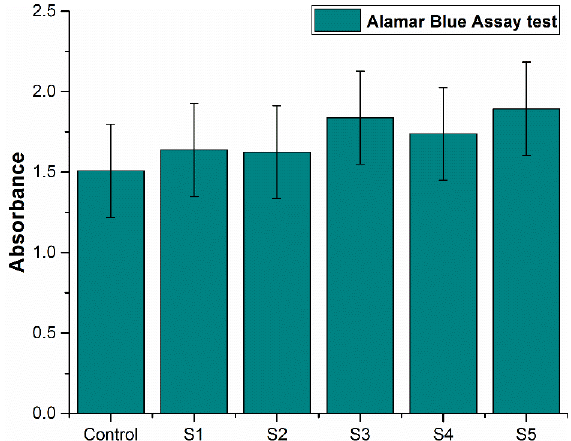
Figure 9. Cytotoxicity assessment of all the specimens. Metals 2019 , 9 , x FOR PEER REVIEW 11 of 14